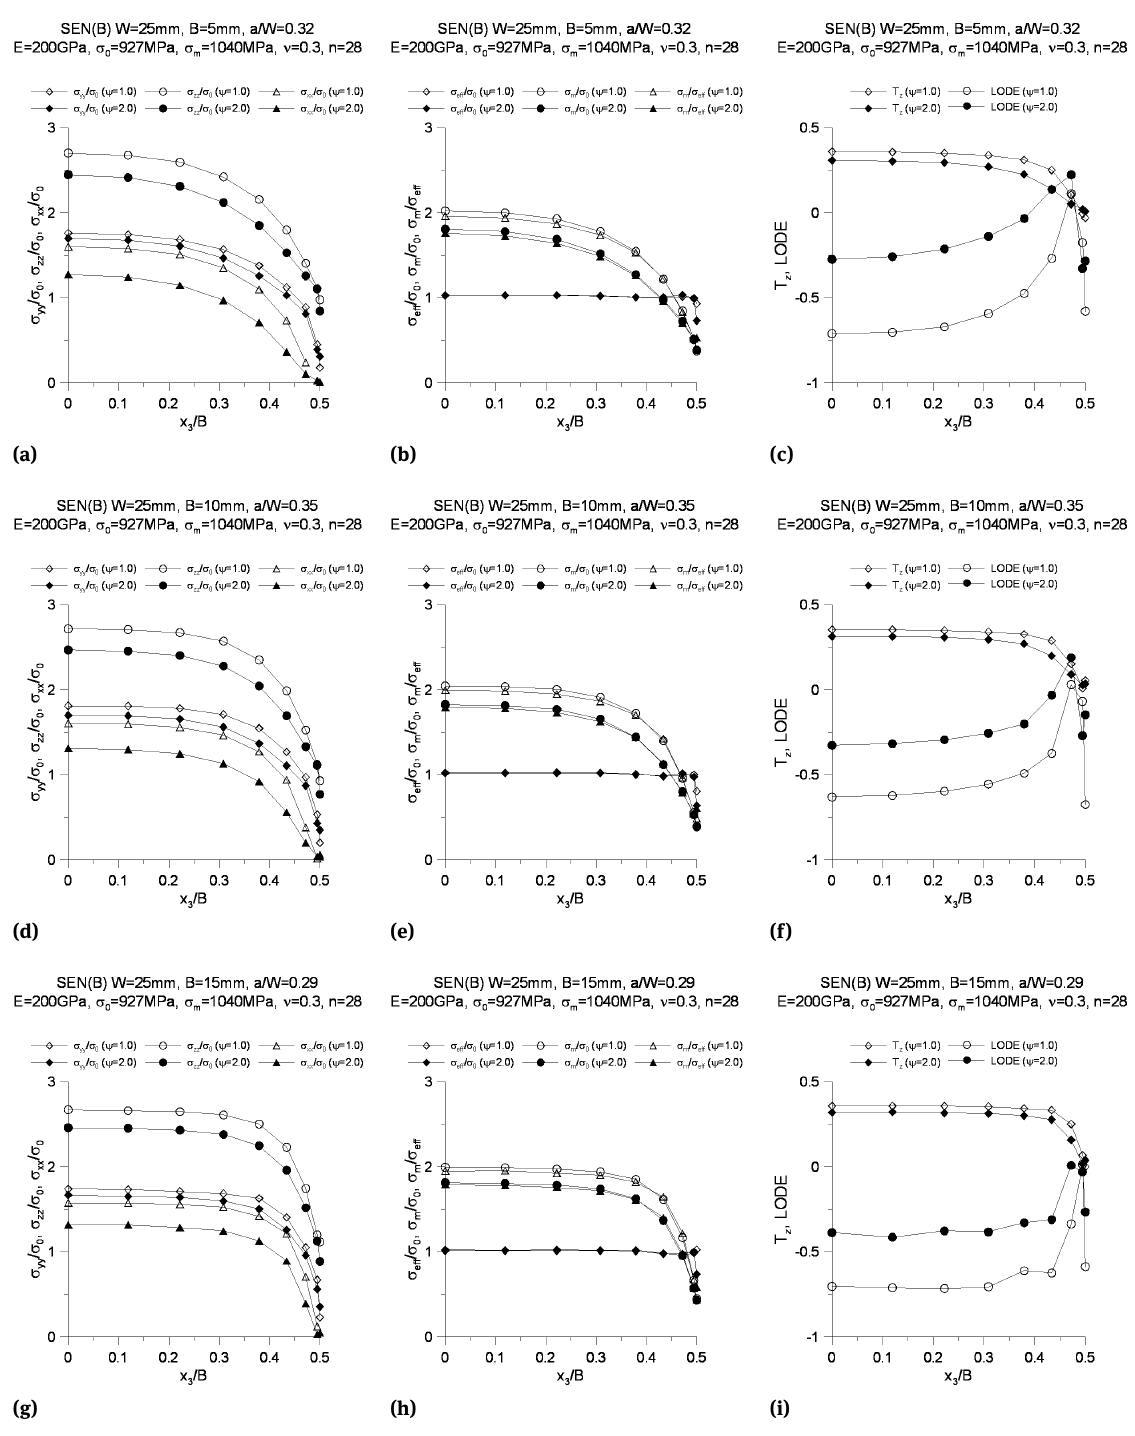
Figure 9: Changes in normal components of the stress tensor ( σ yy / σ 0 , σ zz / σ 0 , σ xx / σ 0 ) and selected measures of stress triaxiality parame- ters ( σ eff / σ 0 , σ m / σ 0 , σ m / σ eff , T z , LODE ) along the crack front, for two selected distances from the crack tip ( r = 1.0 · J / σ 0 and ( r = 2.0 · J / σ 0 ) for three SEN(B) specimens made of 145Cr6 steel: a-c) B = 5mm, a / W = 0.32 ; d-f) B = 10mm, a / W = 0.35 ; g-i) B = 15mm, a / W = 0.29 ( x 3 / B = 0.500 – the edge of the specimen; x 3 / B = 0.000 – the middle plane of the specimen